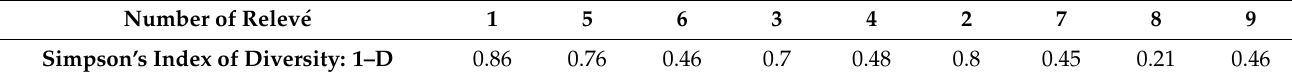
Table 2. Simpson’s Index of Diversity in artificial mixed